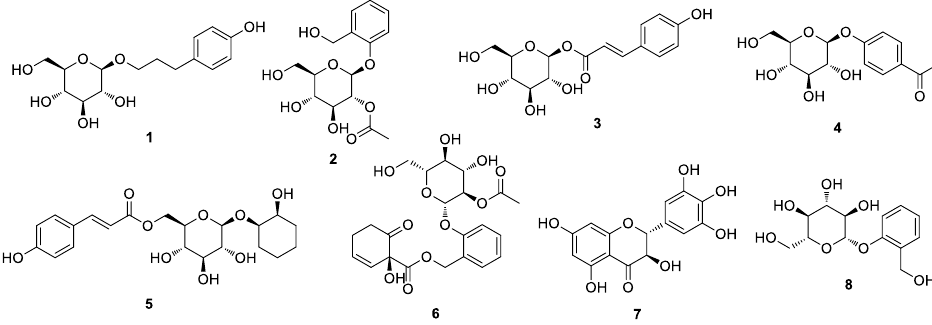
Figure 4. Chemical structures of the marker compounds 1–8 .